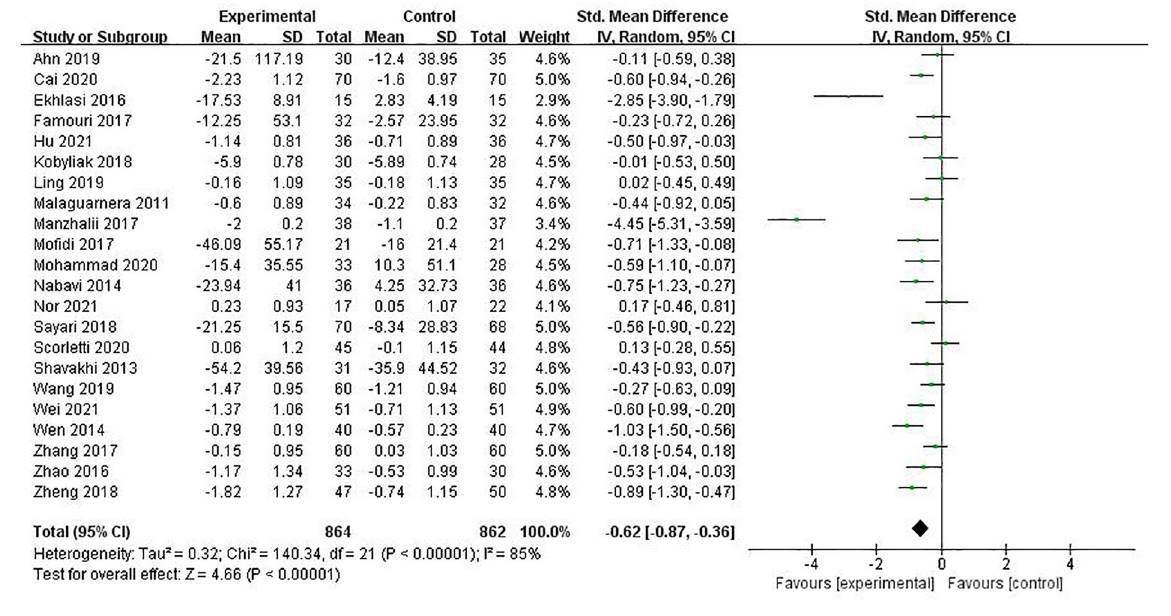
FIGURE6 The role of PPS in TC in patients with NAFLD.